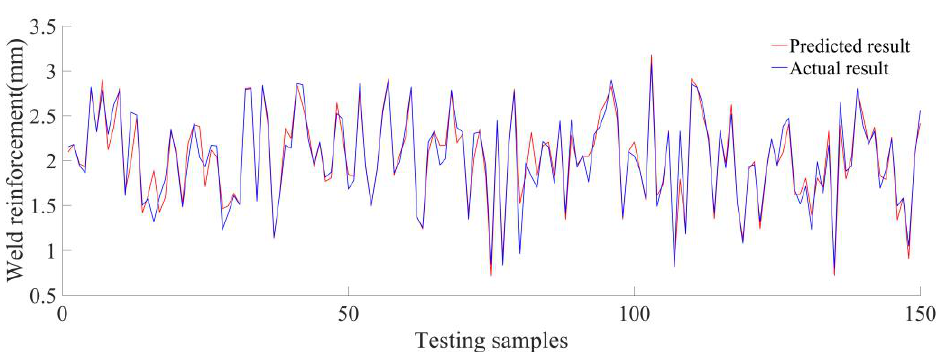
Figure 12. Predicted results of weld reinforcement.